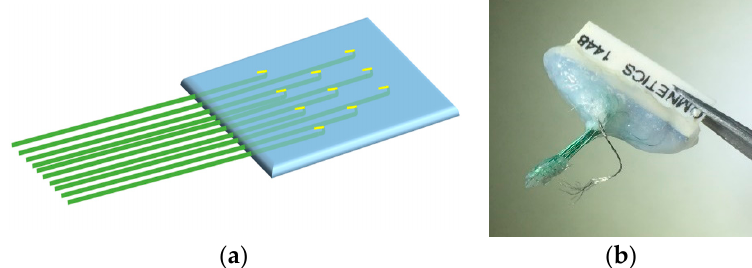
Figure 2. A finished device ( a ) A schematic view of fabricated ECoG electrode as the same as Figure 1j; ( b ) The finished ECoG devices soldered on an omnetics connector.